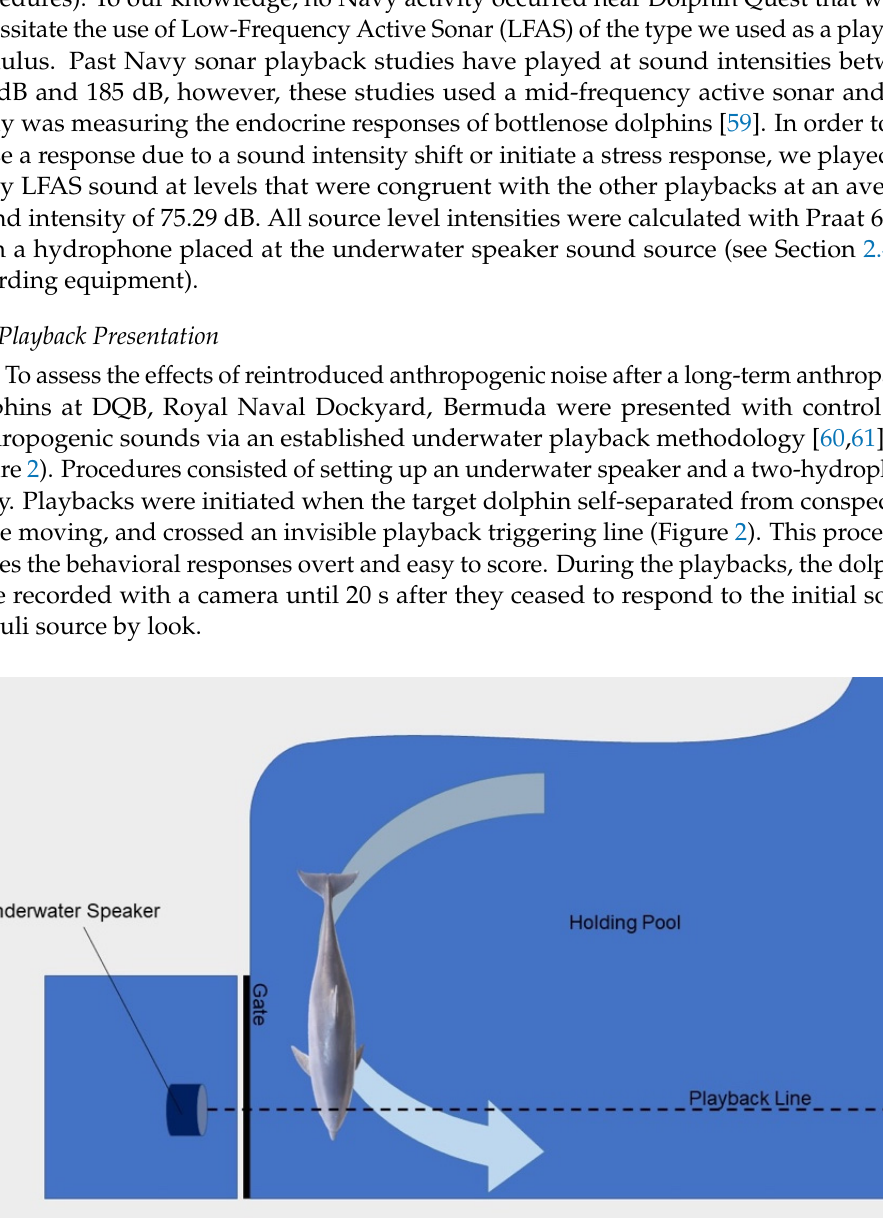
Figure 2. Underwater playback schematic. In the playback paradigm, the sound source is played from an underwater Lubell Labs™ LL16 speaker 0.5–1.0 m from the dolphin’s head to ensure appropriate playback sound levels to the subjects. The sounds are initiated when the target dolphin self-separates from conspecifics and crosses the playback line. Swim direction is indicated with the arrow.